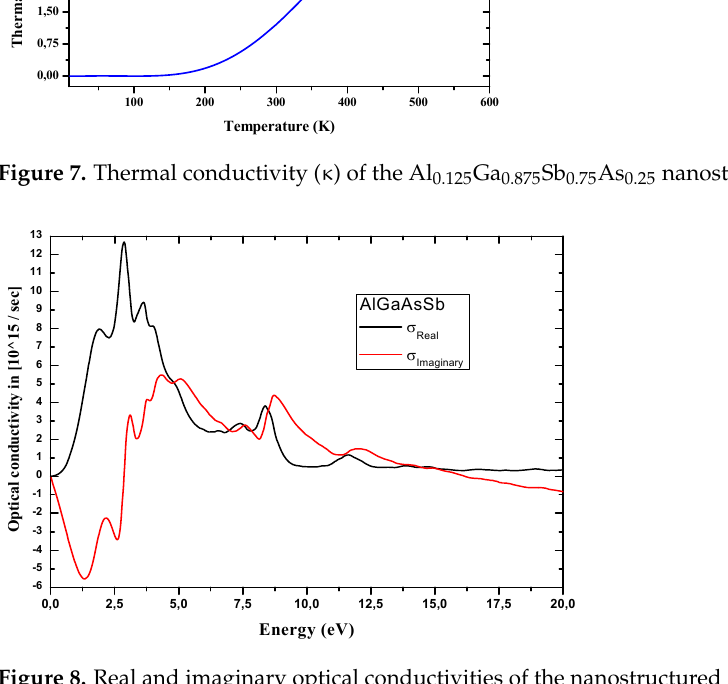
Figure 8. Real and imaginary optical conductivities of the nanostructured Al 0.125 Ga 0.875 Sb 0.75 As 0.25 .